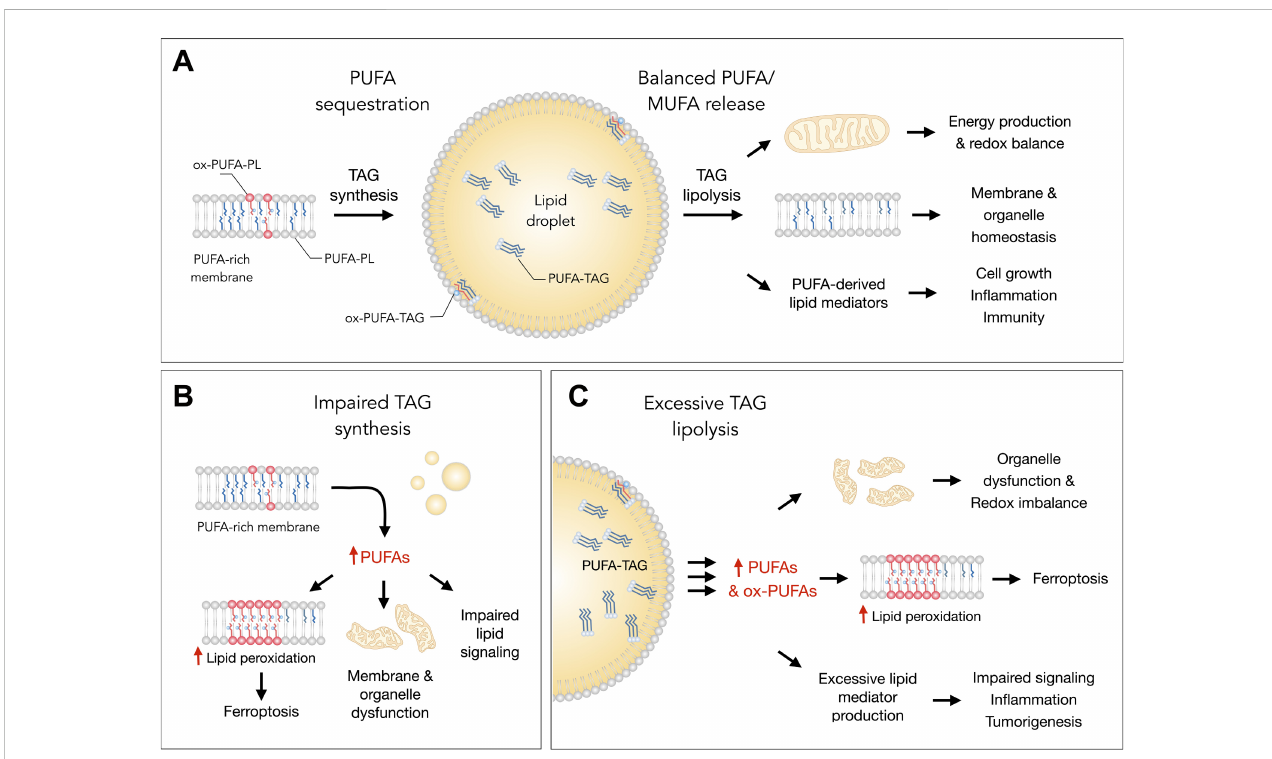
FIGURE 1 Lipid droplets (LDs) control essential cellular processes and protect from ferroptosis by balancing polyunsaturated fatty acid (PUFA) sequestration and release. (A) Underhomeostaticconditions,thebiosynthesisoftriacylglycerols(TAGs)enrichedwithPUFAs(PUFA-TAGs)andtheirpackaginginLDsmaylower the abundance of oxidizable PUFAs esteri fi ed in membrane phospholipids (PUFA-PLs). In principle, already oxidized PUFAs esteri fi ed in phospholipids (ox- PUFA-PLs) could also be transferred into LDs and stored as oxidized TAGs (ox-PUFA-TAGs). On the other hand, the balanced release of monounsaturated fatty acids (MUFAs) and PUFAs via TAG lipolysis maintains proper membrane composition, thereby preventing lipid peroxidation and reducing ferroptosis sensitivity. PUFA release from LDs also supports energy production, mitochondrial function and the redox balance. In addition, lipolysis also delivers PUFAs into oxygenation pathways that convert these FAs into signaling mediators, such as prostaglandins and leukotrienes, which regulate various cellular functions, including cell growth, in fl ammation and immunity. (B) Under various stress conditions, impaired TAG synthesis may lead to an enrichment of membranes with PUFAs that can result in elevated lipid peroxidation and ferroptosis. Excess PUFAs may also overload mitochondria and other organelles, as well as disrupt the biosynthesis of lipid mediators. (C) Excessive breakdown of LDs by neutral lipases (at the lipid droplet surface) or acid lipases (in the lysosome) during acute or chronic stress may disrupt organelle function, impair redox signaling and metabolism, and enrich membranes with PUFAs. This can increase lipid peroxidation levels and sensitivity to ferroptosis. The release of excess PUFAs from LDs may also stimulate the production of pro- in fl ammatory and pro-tumorigenic lipid mediators, which can overstimulate mitogenic, in fl ammatory and other signaling